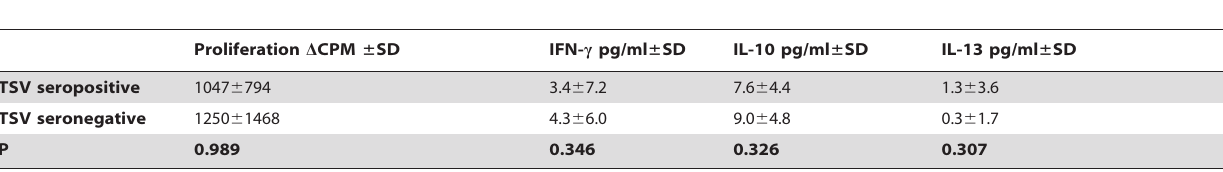
Table 2. Comparison of background (Media) proliferation and cytokine responses among TSV-seropositive and seronegative